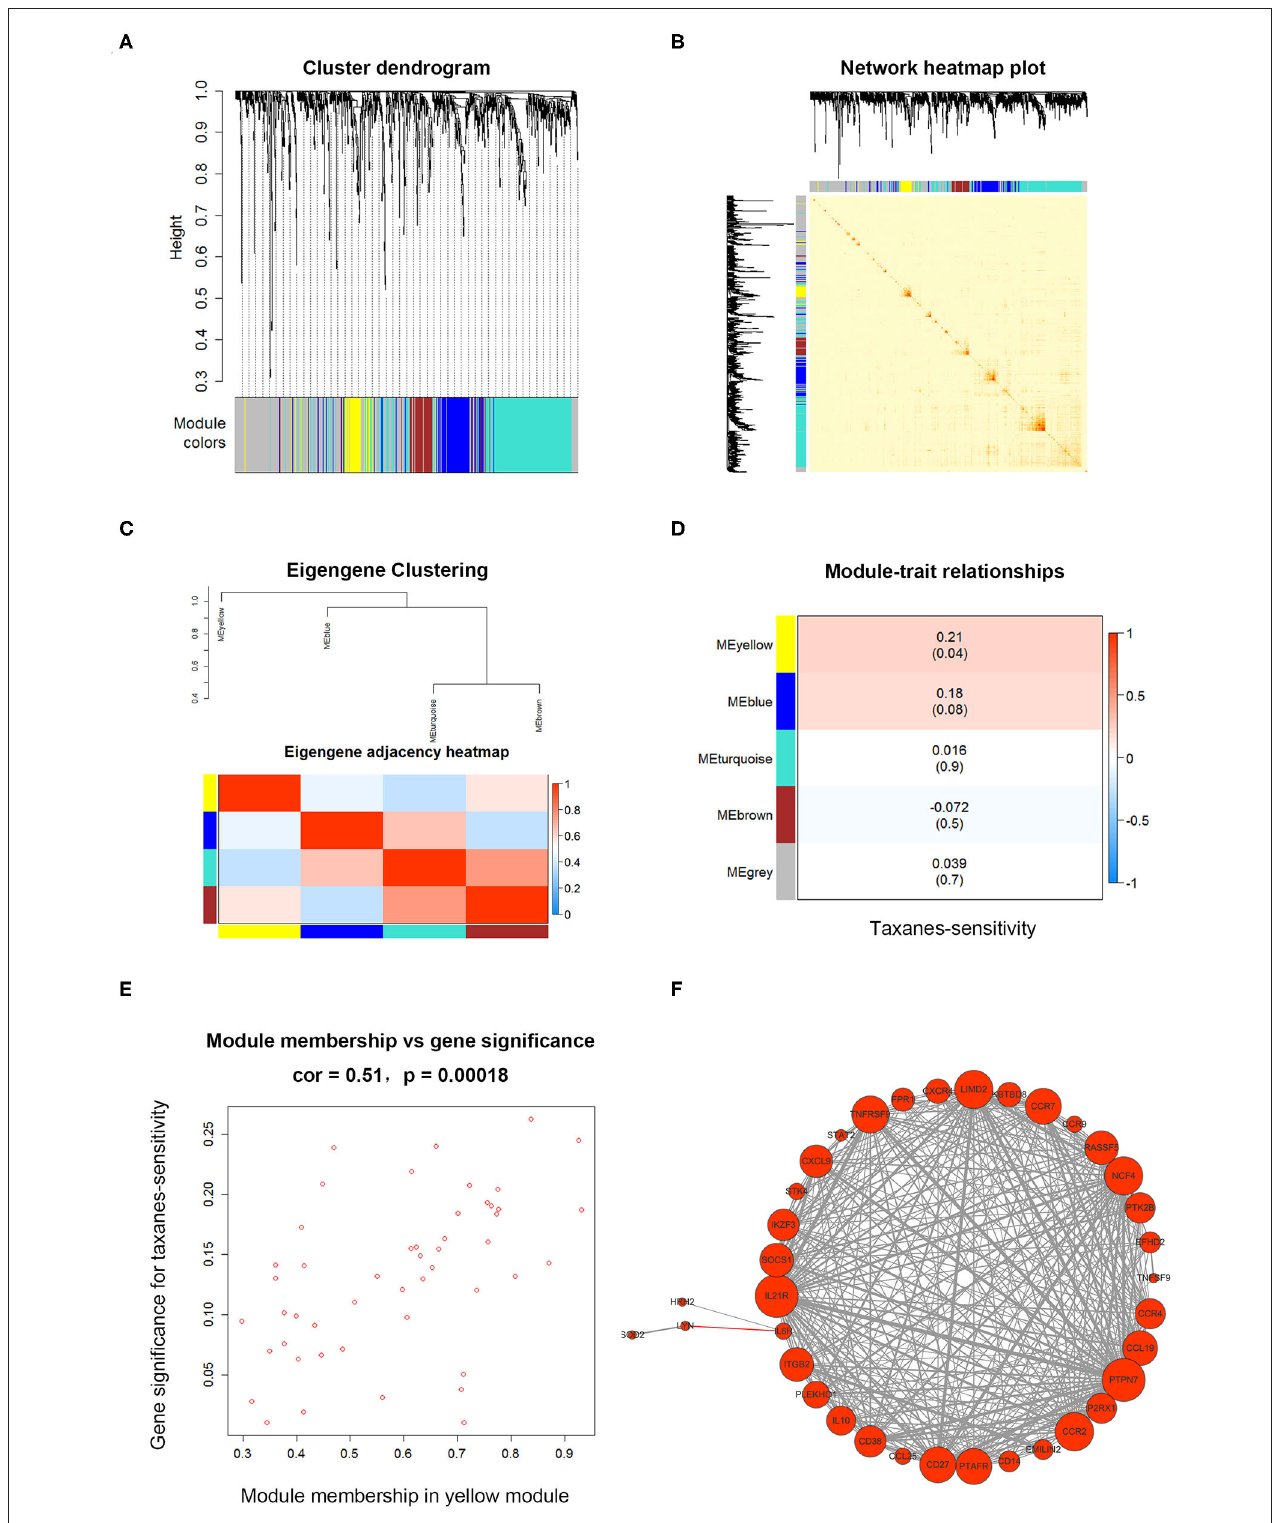
FIGURE 3 | The WGCNA for candidate target genes of miR-335-5p and let-7c-5p. (A) Clustering dendrogram of target genes of miR-335-5p and let-7c-5p, with dissimilarity based on Topological Overlap Measure (TOM). Genes were divided into five assigned merged modules, including 350 genes in gray module represented not co-expressed. (B) Interactive relationship analysis of co-expression genes in different modules. The brightness of yellow in the middle suggested a high-scale